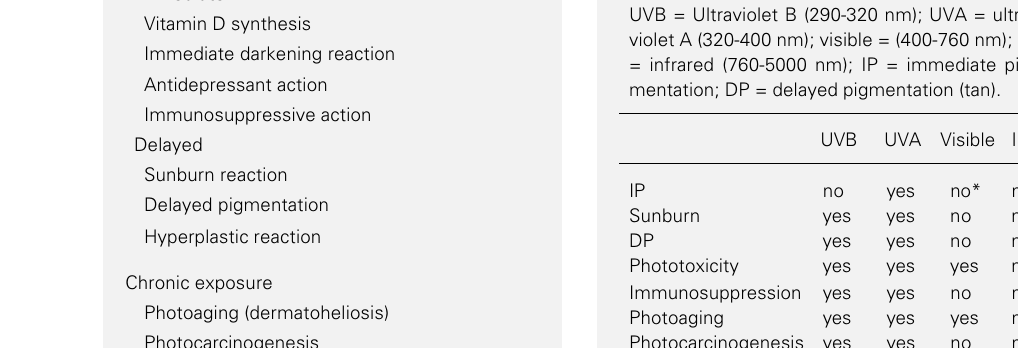
Table 2 - Photobiological effects of different parts of the spectra of solar irradiation. *Heavily pigmented individuals can get immedi- ate pigmentation when exposed to visible